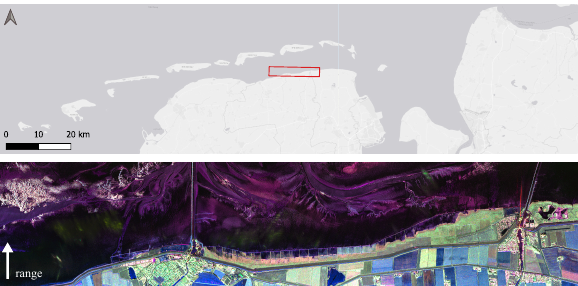
Figure 1. Top: Geographic location of the study site. Bottom: PolSAR image (S-band) color coded corresponding to the Pauli